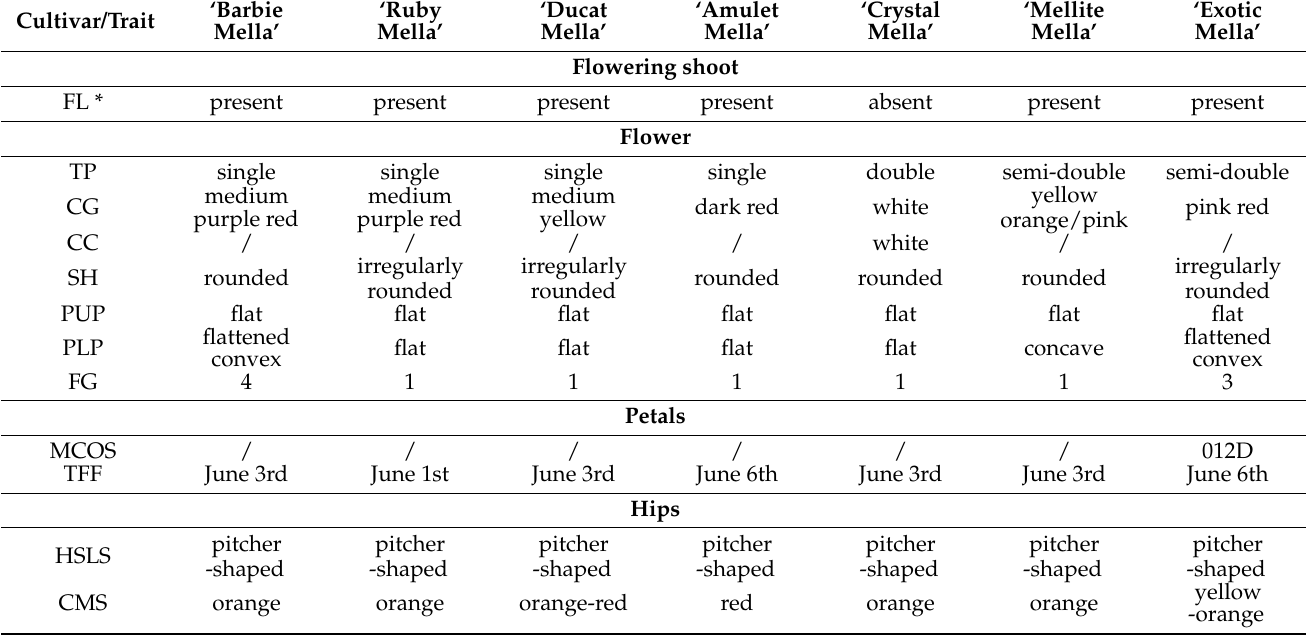
Table 2. Qualitative generative characteristics of the investigated ‘Mella’ rose collection.